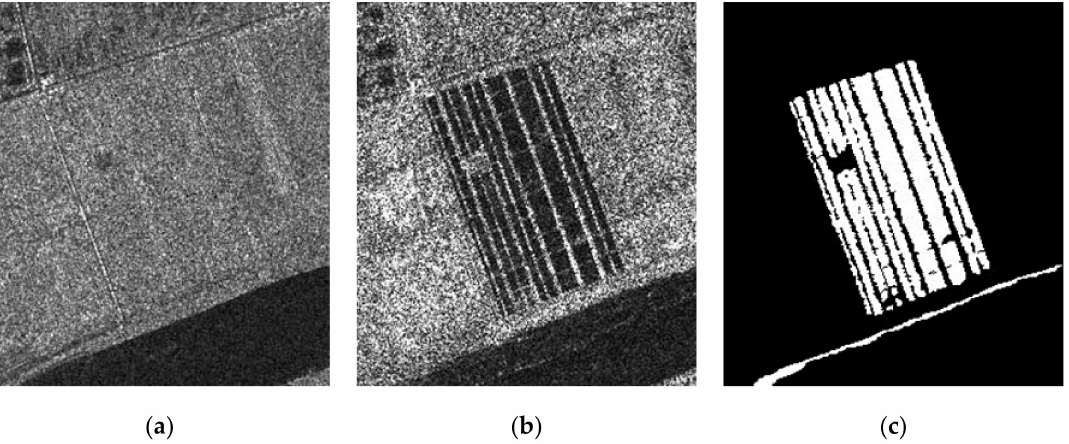
Figure 7. Farmland A dataset. ( a ) Image acquired in June 2008. ( b ) Image acquired in June 2009. ( c ) Ground